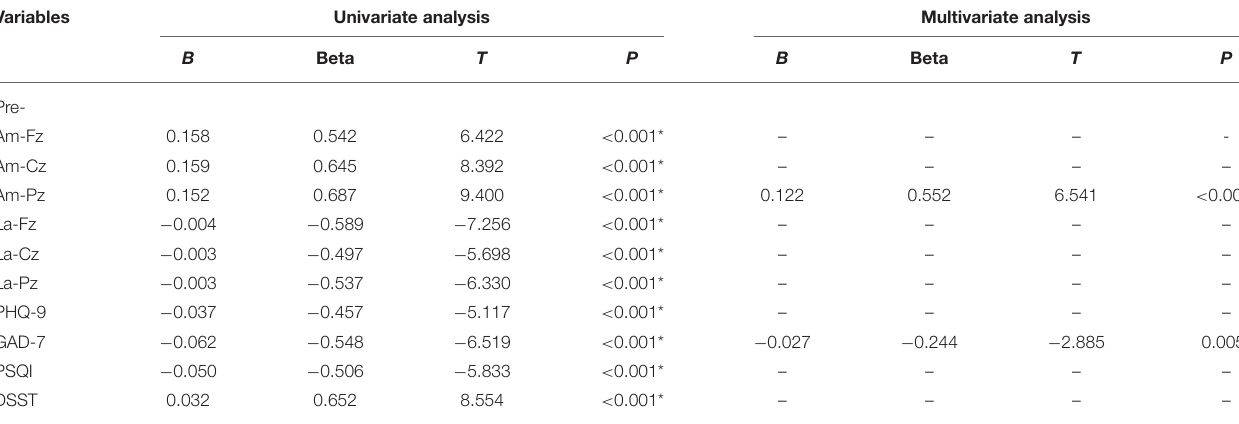
TABLE 7 | Factors associated with therapeutic effect on alcohol dependence by linear regression analysis ( n = 101). Variables